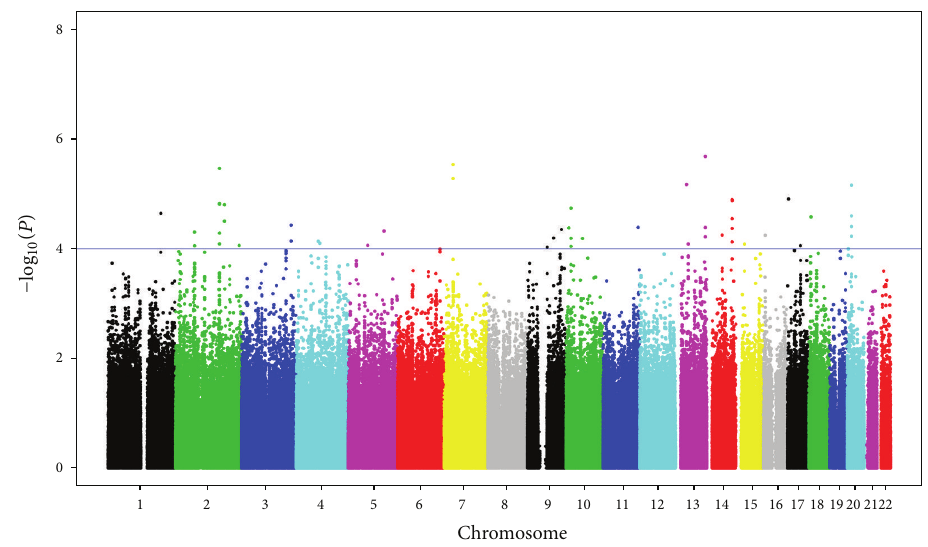
Figure 4: Manhattan plot showing the genome-wide association 𝑃 values with anti- 𝛽 2 glycoprotein I antibodies (Anti- 𝛽 2 GPI). Blue line indicates 𝑃 = 1𝐸 − 04